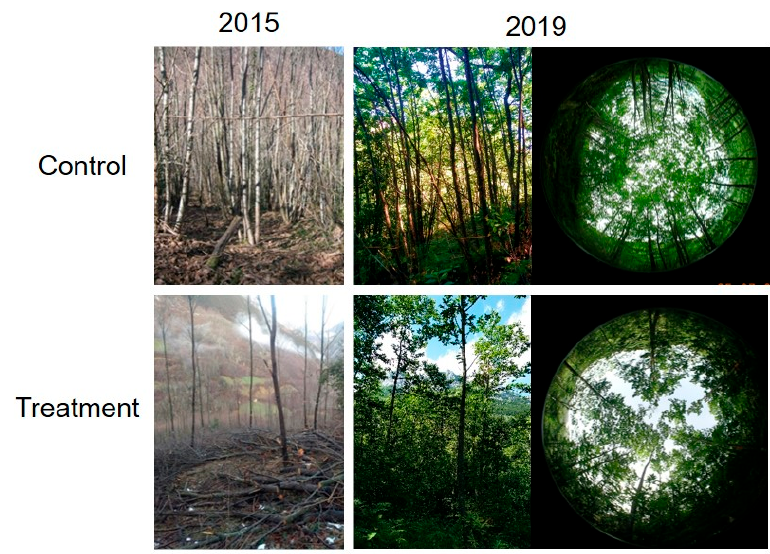
Figure 2. Examples of Treatment 1 after thinning in 2015 (set up year), and in 2019 when LAI e measurements in the field were carried out.